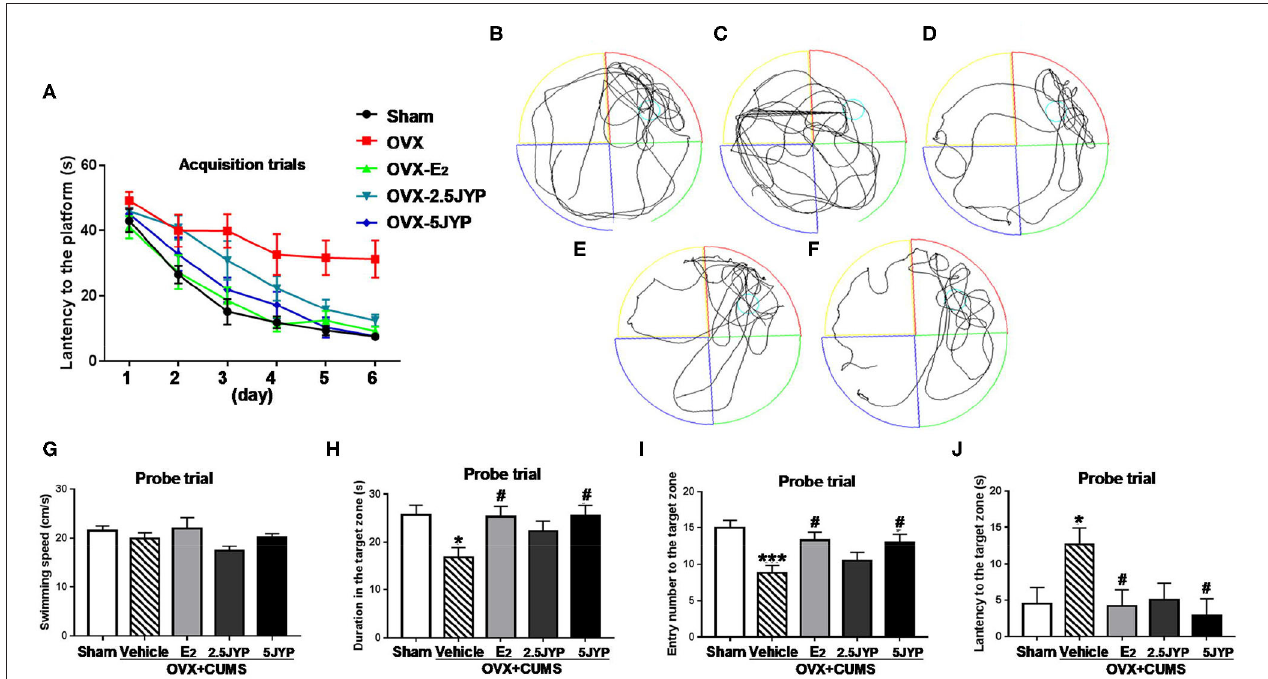
FIGURE 5 | Effects of 2.5 g/kg JYP (2.5 JYP), 5.0 g/kg JYP (5 JYP), and 0.3 mg/kg estradiol (E2) in Morris water maze test of OVX + CUMS mice: escape latency in the acquisition trials (A) ; representative individual swim paths in the probe trial of sham group (B) , vehicle group (C) , E 2 group (D) , 2.5 JYP group (E) , and 5 JYP group (F) ; swimming speed (G) , duration in the target zone (H,I) entry number into the target zone (I) , and latency to the target zone (J) in the probe trial. Data are expressed as mean ± SEM ( n = 9–10) and examined with two-way or one-way analysis of variance (ANOVA) and one-way ANOVA, followed by followed by post hoc between-group comparisons: * P < 0.05, *** P < 0.001 vs. sham group; # P < 0.05 vs. vehicle